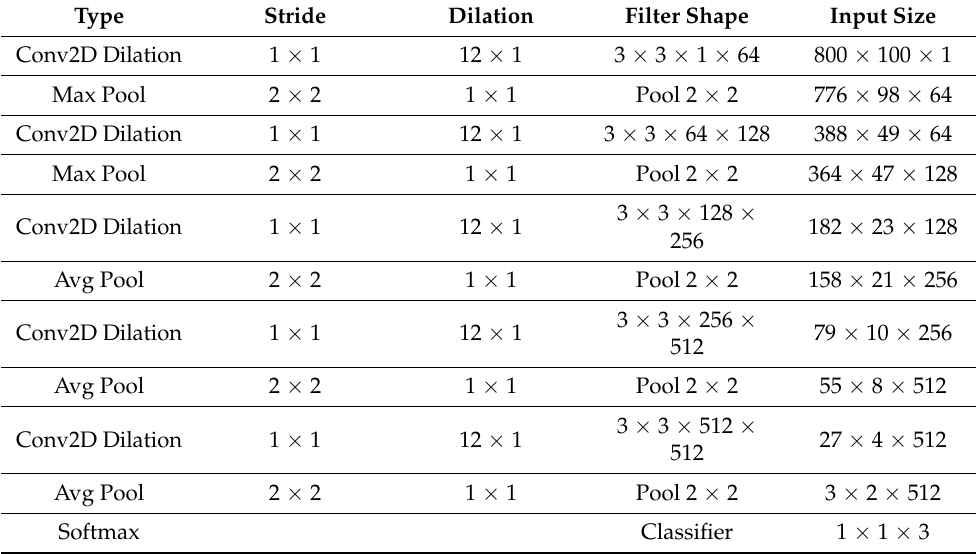
Table 4. The structure of the time-dilated convolutions. Type Stride